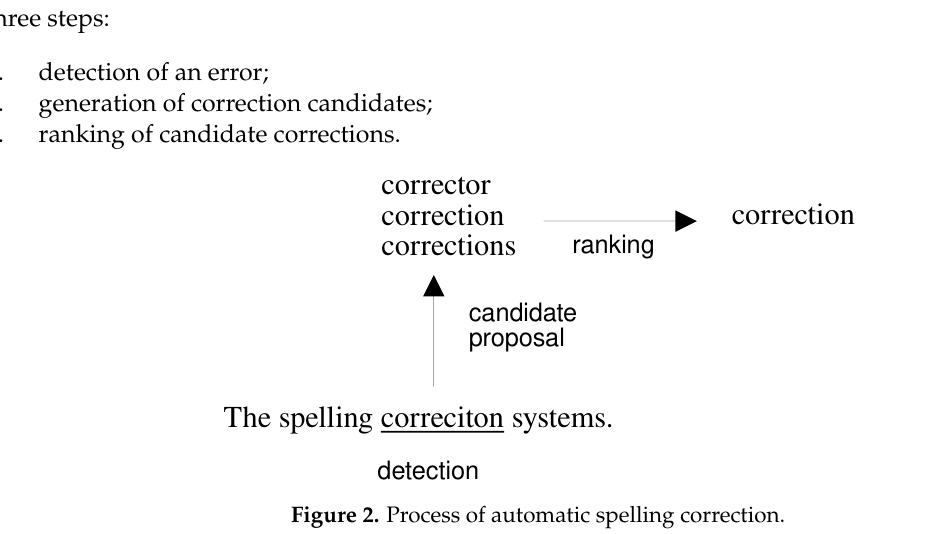
Figure 2. Process of automatic spelling